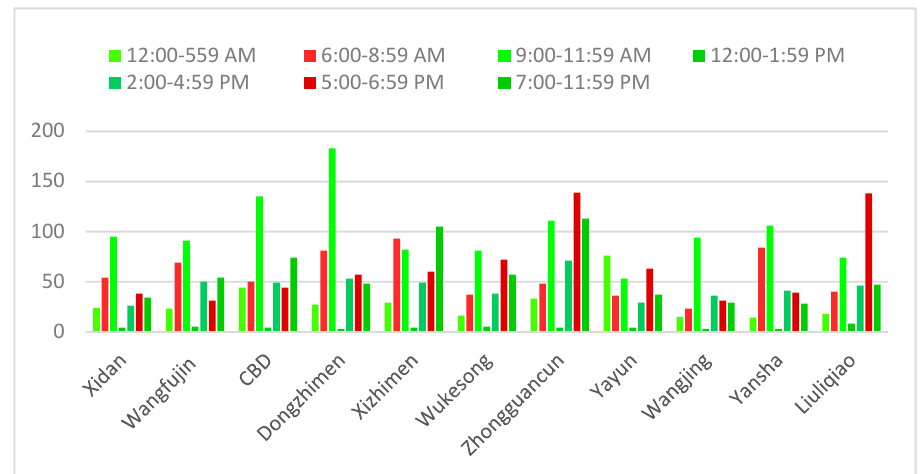
Figure 5. Predictive accuracy ratio between peak and off-peak times. 385